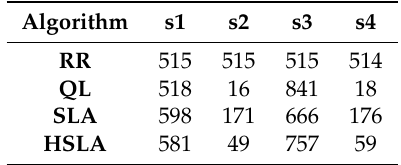
Table 6. Server (feeder link) selection count for Scenario-1 (GET).